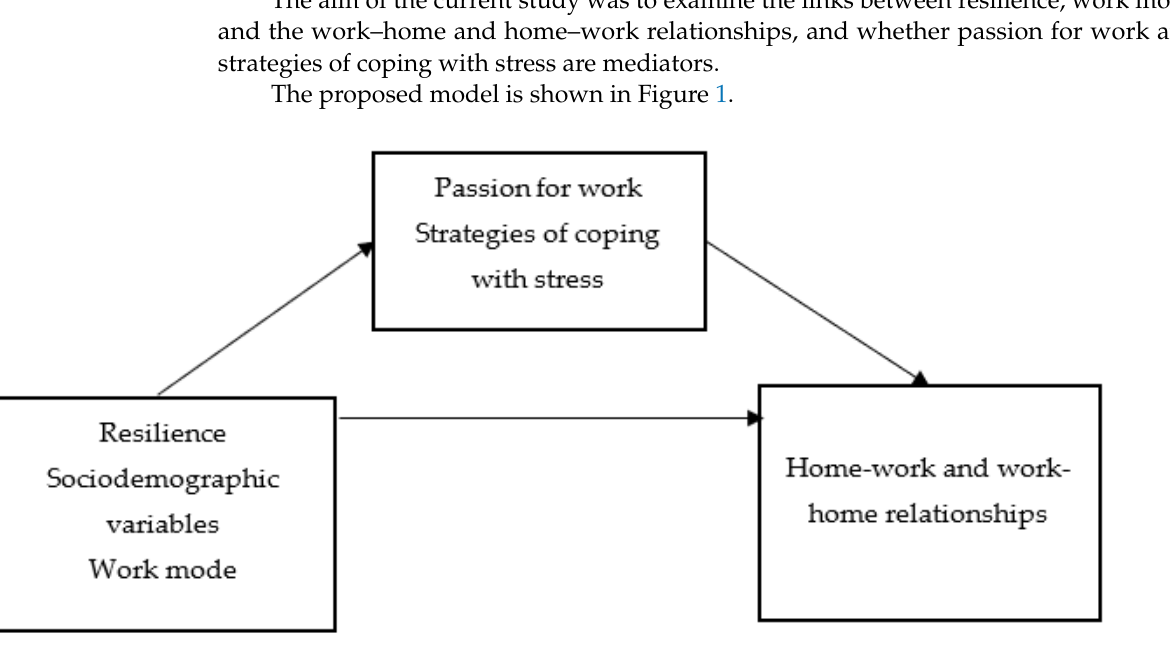
Figure 1. Proposed research